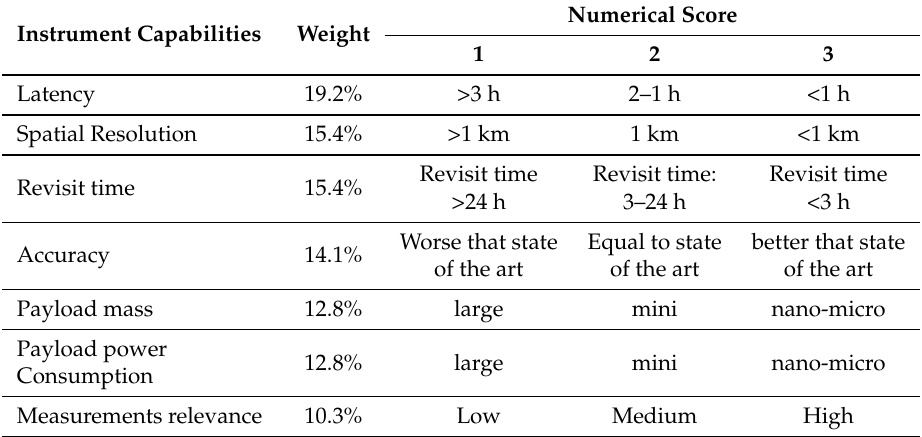
Table 9. Definition of the numerical score for the criteria and result of the weights.